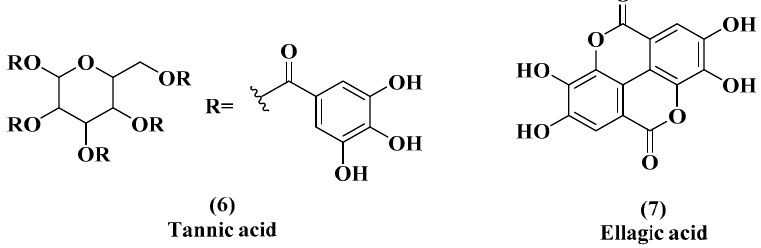
Figure 4. Tannic acid ( 6 ) and ellagic acid ( 7 ), quorum sensing inhibitors.